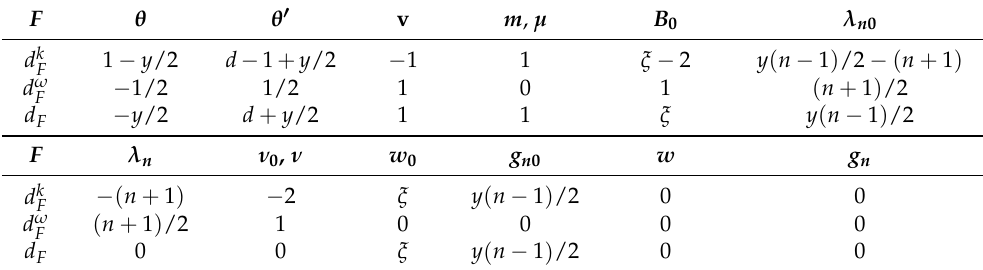
Table 1. Canonical dimensions of the fields and the parameters in the model (10) and